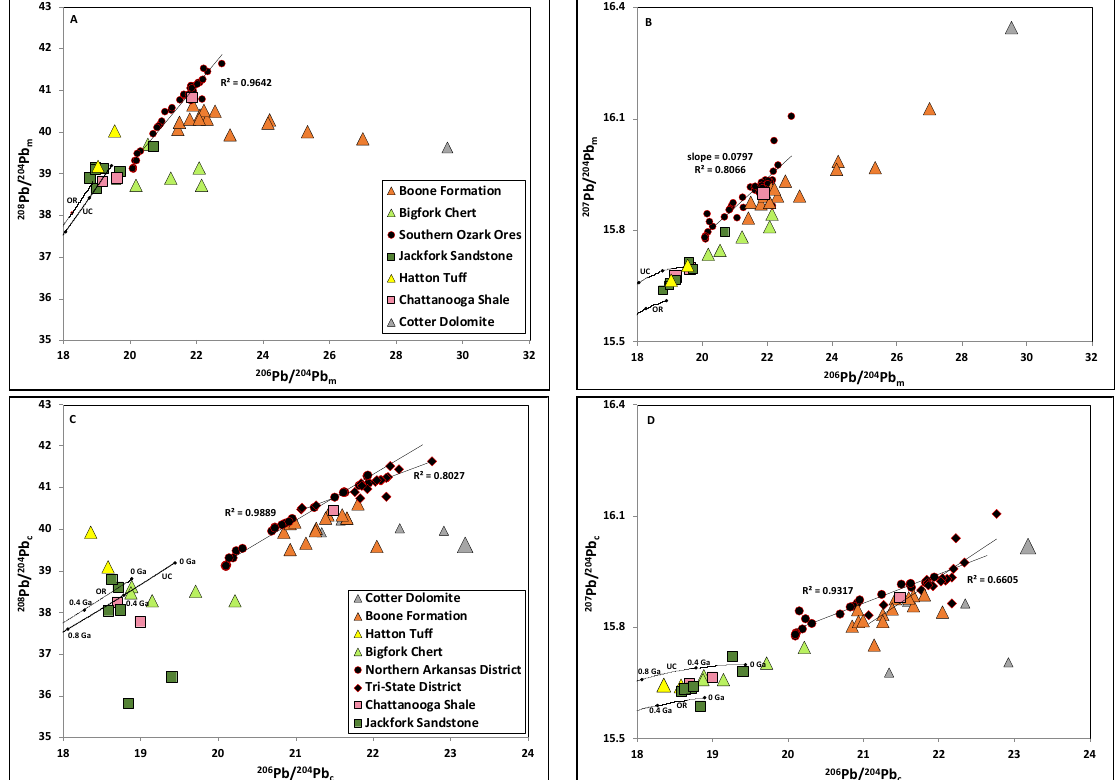
Figure 6. Measured ( A , B ) and age-corrected ( C , D ) Pb isotope ratios of analyzed samples. Additionally shown are published results of Chattanooga Shale [9], Jackfork Sandstone [10], and MVT ores from the Northern Arkansas and the Tri-State mining districts [9,28,80]. Linear trends through the MVT ores from the southern Ozark region ( A , B ), Northern Arkansas ( C , D ), and Tri-State ( C , D ) are also displayed. The average orogene (OR) and upper crust (UC) growth curves are included [81]. In total, four of the Cotter Dolomite samples with µ ( 238 U/ 204 Pb) values over 200 have been omitted from the measured Pb isotope plots ( A , B ) and represented with smaller symbols on the age-corrected Pb isotope plots ( C , D ). Overall, the tripolitic chert samples of the Boone Formation have lower measured 208 Pb/ 204 Pb and 207 Pb/ 204 Pb values for a given 206 Pb/ 204 Pb compared to the MVT ores (Figure 6A,B). Except for the Hatton Tuff, all analyzed samples plot to the right of both growth curves, with the Cotter Dolomite samples displaying the highest 207 Pb/ 204 Pb